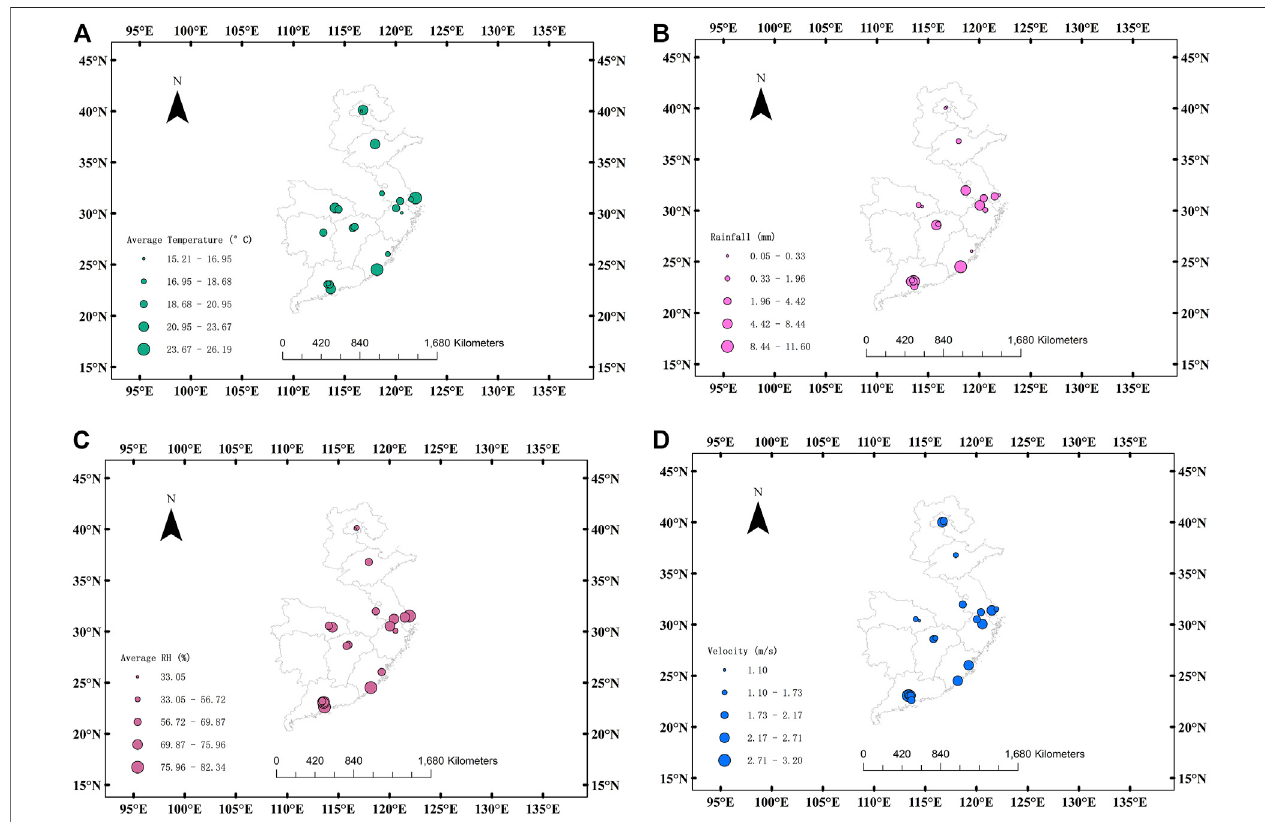
FIGURE 4 | Geographical distribution of annual average air temperature (A) , rainfall (B) , average relative humidity (RH) (C) , and wind velocity (D) in urban wetland parks. Spots in dark red, light blue, green, and pink mark annual average air temperature, rainfall, average RH, and wind velocity, respectively. The size of a spot and its adjacent value together remark the average of records when visitors posted their photographs to Sina Weibo at the aimed places.